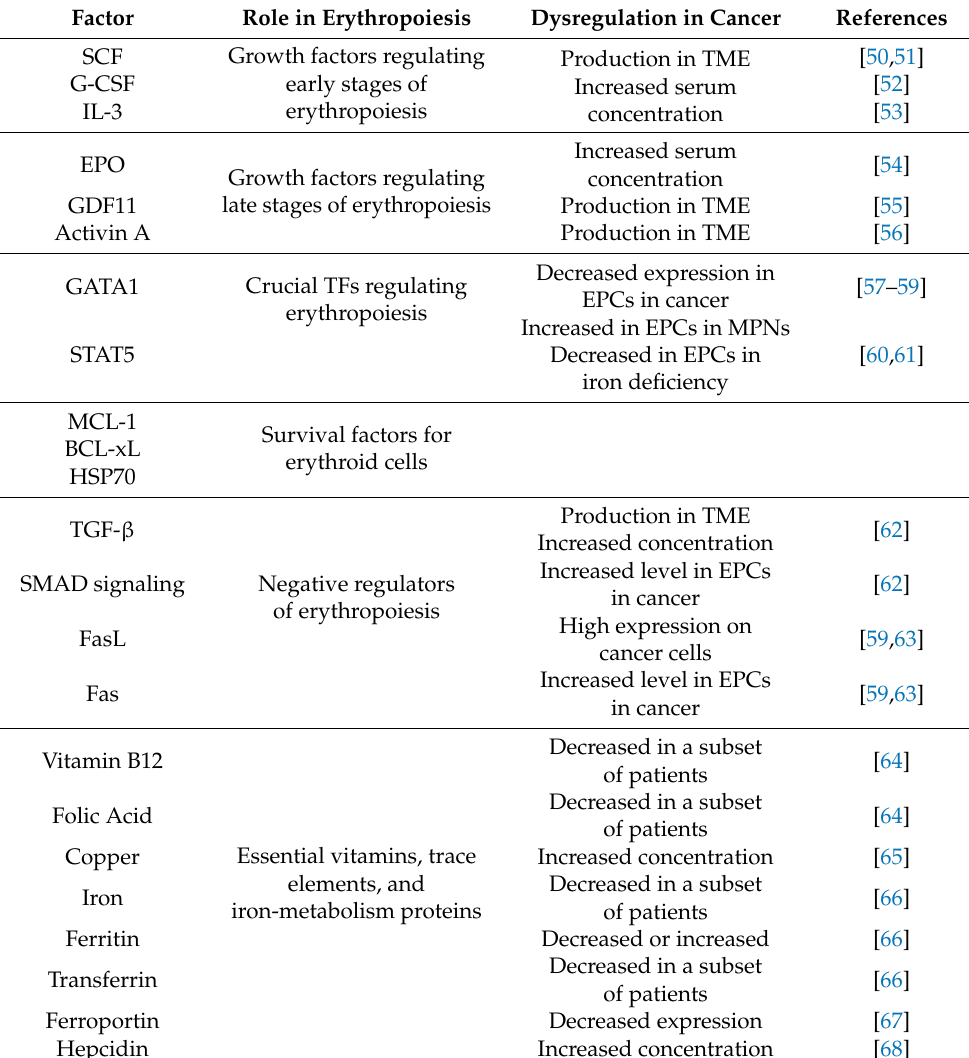
Table 2. Regulation of